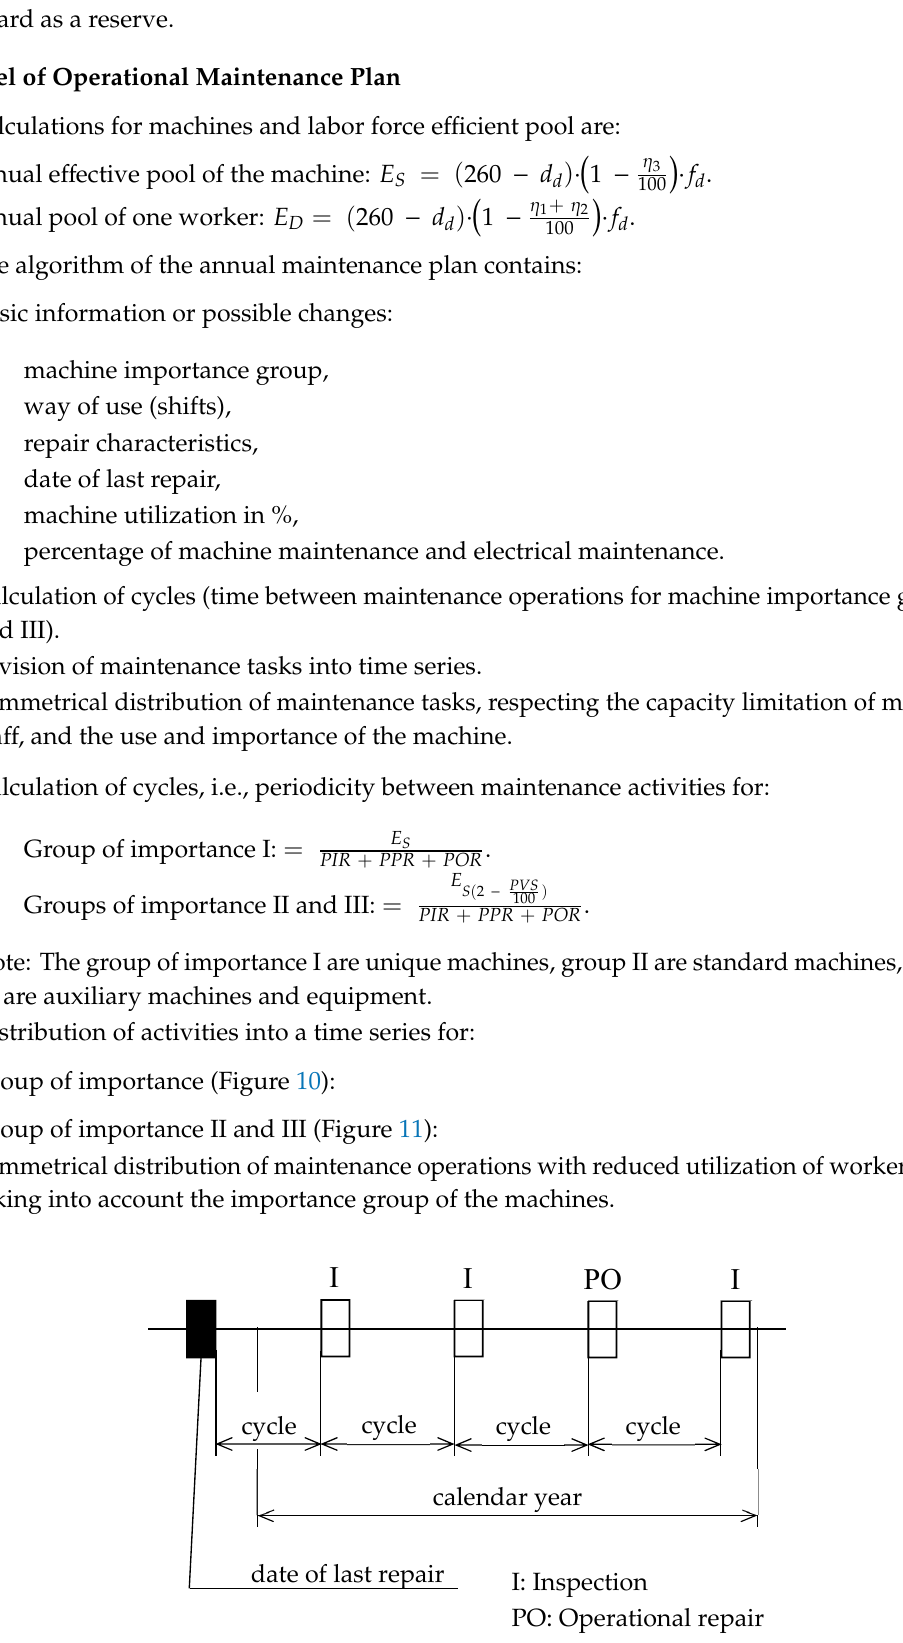
Figure 10. Annual maintenance plan for group of importance I